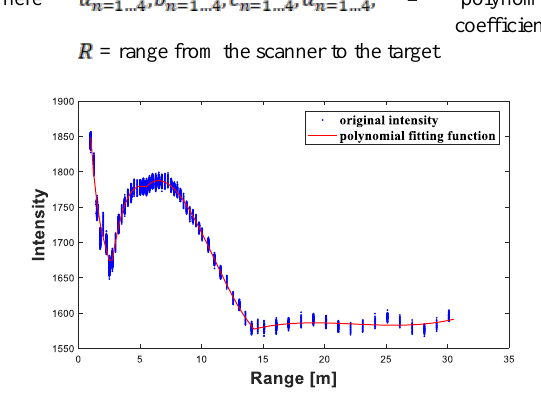
Figure 3. Original intensity with respect to range and fitted intensity-range function Figure 5. Original intensity with respect to incidence angle and fitted intensity-incidence angle function Through polynomial fitting, the coefficients can be derived. The calculation values of each coefficient are listed in Table 2. The intensity data before and after correction are shown in Figure 6. After correction, the intensity data acquired at different incidence angles are approximately equal.